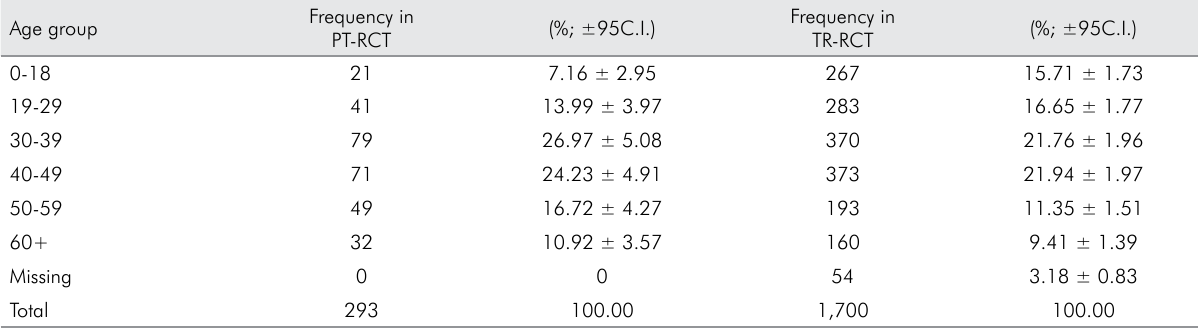
Table 2. Frequency and distribution of apical radiolucency among teeth with previous endodontic treatment (PT-RCT) and among teeth referred for endodontic treatment (TR-RCT) by age group (n =1,993) Age